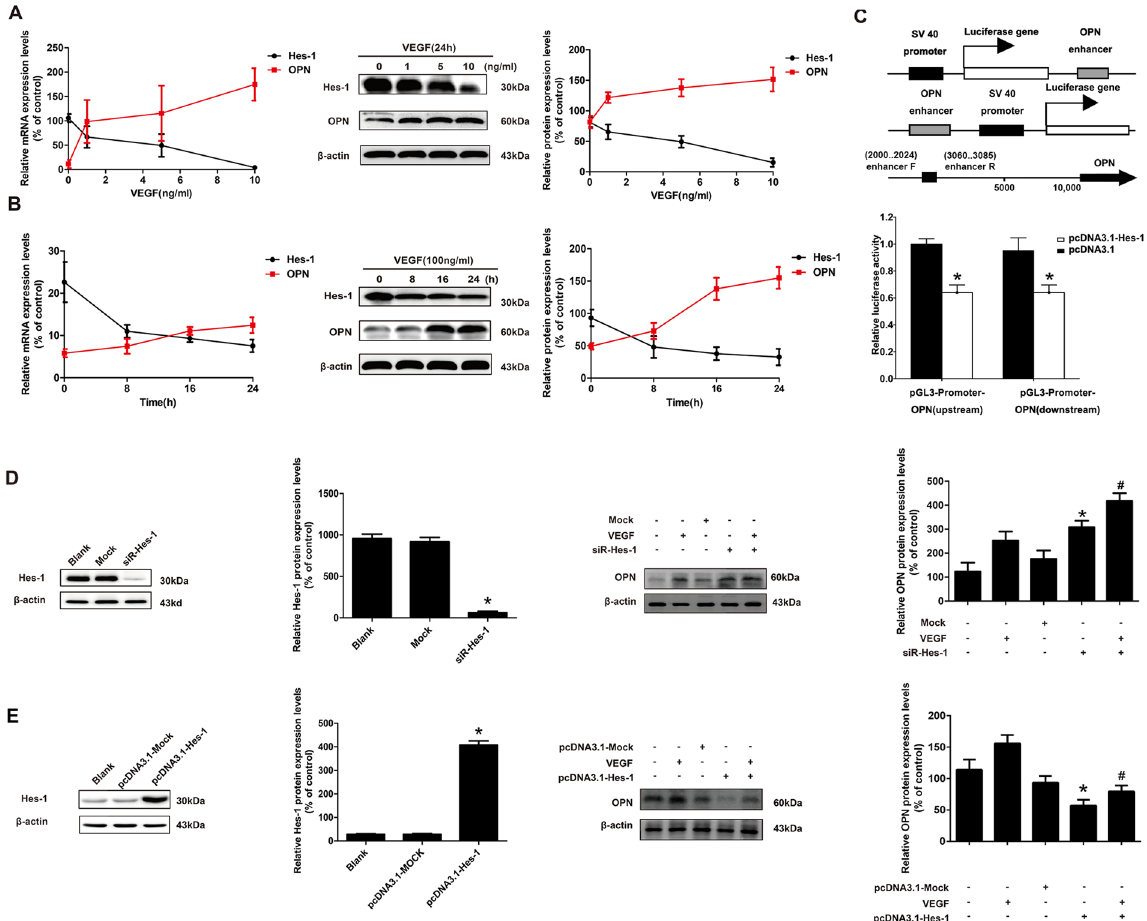
Figure 3. Hes-1 is involved in VEGF-induced up-regulation of OPN expression in HUVECs. ( A to B ) HUVECs were treated with VEGF at 0, 1, 5, and 10 ng/mL for 24 hours or treated with 10 ng/mL of VEGF for 0, 8, 16, and 24 hours, respectively. Hes-1 and OPN transcript levels were measured by real-time quantitative PCR and protein expression was assessed by western blotting. ( C ) Diagrammatic representation of the constructs used in the luciferase reporter assays and the luciferase activities of enhancer-SV40 promoter-Luc and SV40 promoter-Luc-enhancer compared with their counterparts. 293 T cells were cotransfected with pcDNA3.1- Hes-1 or a control vector and a luciferase reporter construct containing the the OPN enhancer. Luciferase activity was assayed 24 h after transfection. Firefly luciferase activity of each sample was normalized by Renilla luciferase activity. Data were normalized to the luciferase activity detected in cells transfected with the control vector. * p < 0.05 ( D ) Western blotting analysis of relative Hes-1 expression levels in HUVECs transfected with mock or siRNA-Hes-1 for 24 h. HUVECs were treated with mock or siRNA-Hes-1 and then incubated with or without 10 μ g/mL of VEGF for 24 h. ( E ) Western blotting analysis of the relative Hes-1 expression levels in HUVECs transfected with pcDNA3.1-mock or pcDNA3.1-Hes-1 for 24 h. HUVECs were treated with pcDNA3.1-mock or pcDNA3.1-Hes-1 and then incubated with or without 10 μ g/mL of VEGF for 24 h. OPN protein contents were measured by western blotting analysis. β -actin was used as a loading control. All results are presented as the mean ± SD of three independent experiments, each performed in triplicate. * p < 0.05 compared with the blank group. # p < 0.05, compared with the VEGF